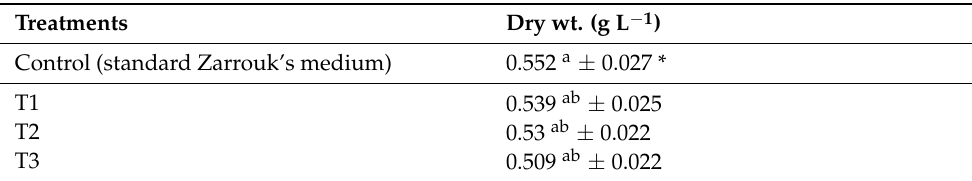
medium concentrations (100%, 50%,